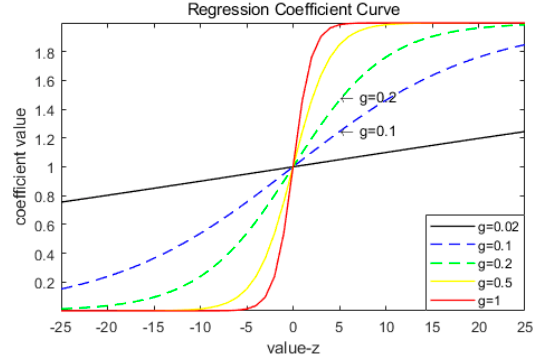
Figure 5. Graph of different g values.